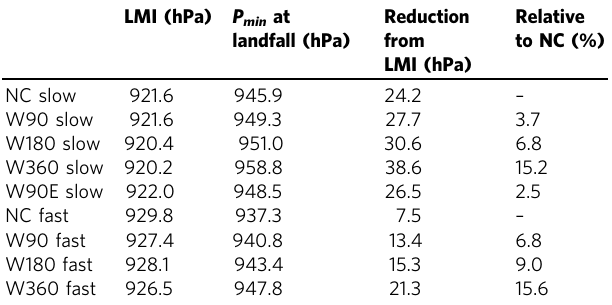
landfall (hPa), absolute reduction in P min at landfall from the LMI (hPa), and the additional percent reduction relative to the corresponding NC case and normalized by the LMI.